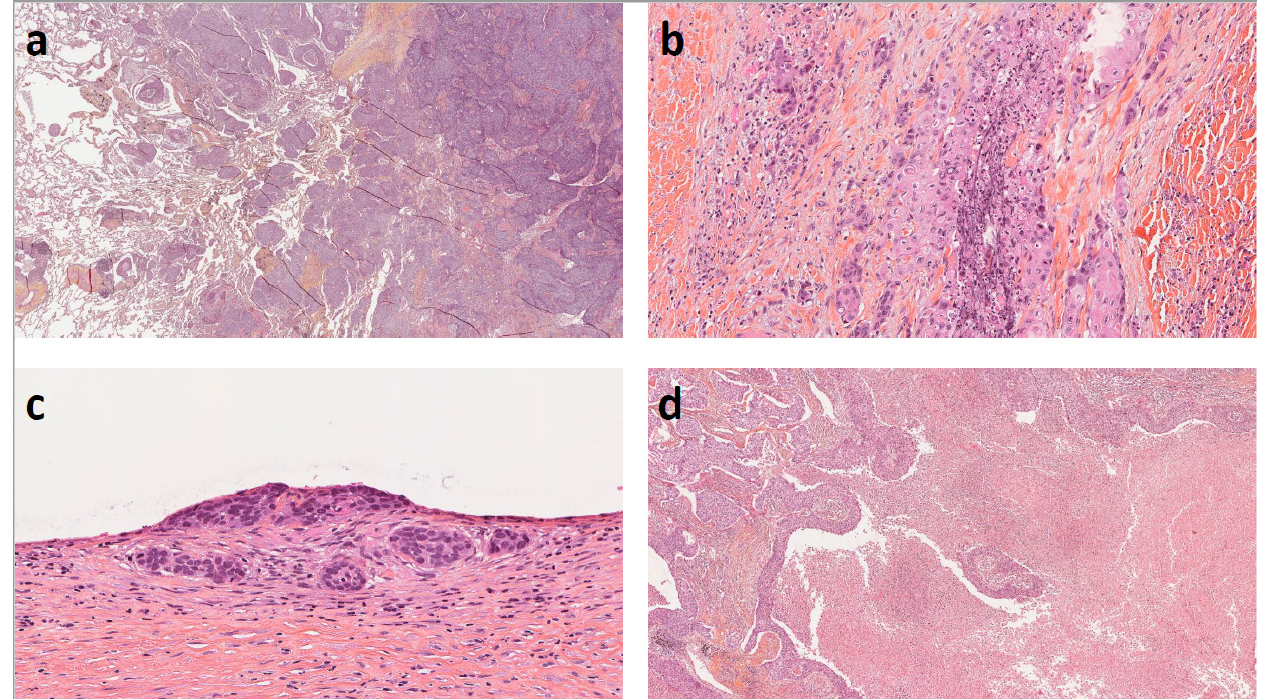
Figure 1. Illustrative microphotographs of histopathological parameters : ( a )—Hematoxylin, Eosin and Saffron (HES) × 25, STAS. ( b )—HES × 100, Tumor budding and single cell invasion. ( c )—HES × 200, Pleural invasion PL2. ( d )—HES × 25, Extensive tumor necrosis.